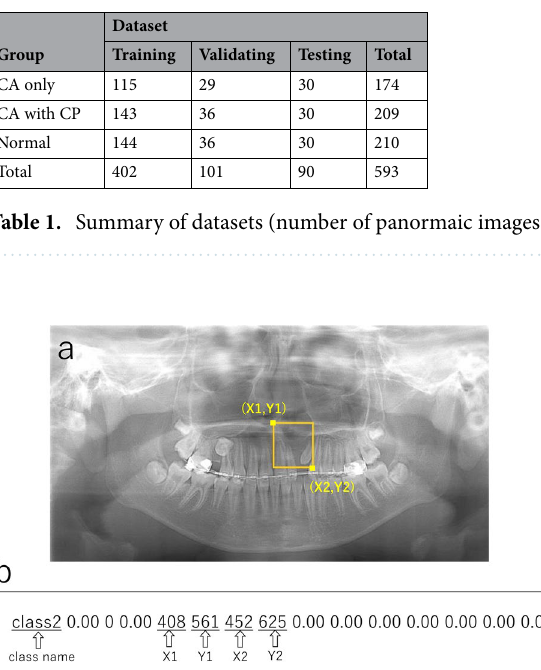
Figure 1. (a) The label including the cleft alveolus is created by setting a rectangular region of interest (ROI). The superior distal corner was set at the point including the equivalent level to the contralateral normal line of the piriform aperture’s lower limit and the most distal portion of the piriform aperture. The inferior medial corner was set at the alveolar ridge between the central incisors. (b) The coordinates of upper left and lower right corners of the ROIs were converted to text